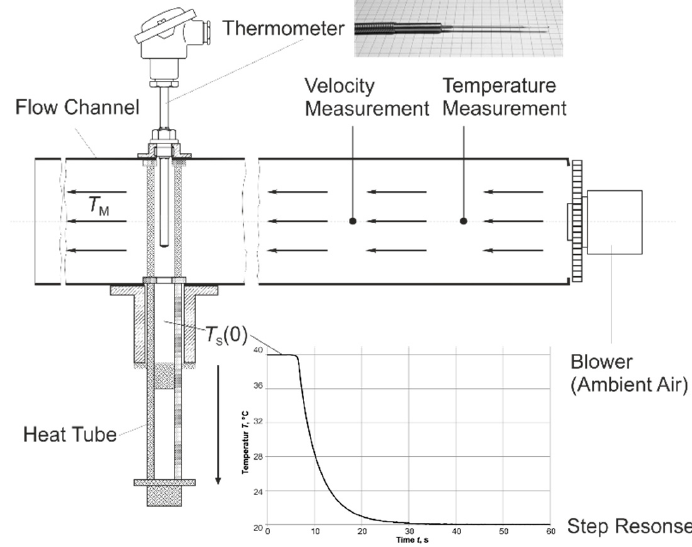
Figure 2. Schematic set-up for the experimental determination of the dynamic behavior of thermometers. Figure2.